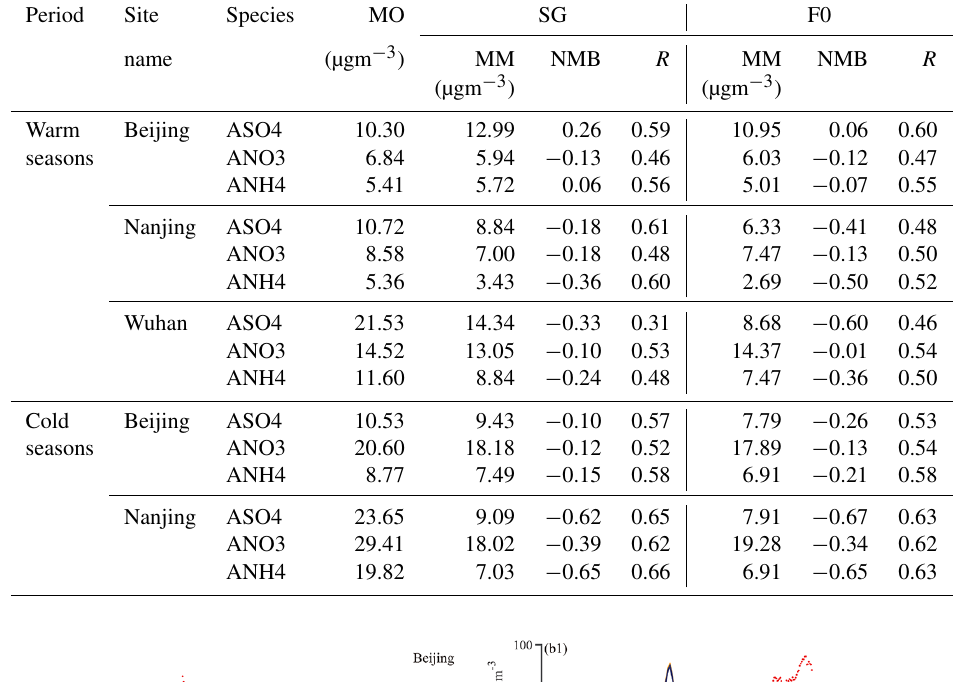
Table 4. Summary of statistics for hourly mass concentration of aerosol components in different seasons. MO, MM, NMB and R represent the mean value of the observations, the mean value of the model, normalized mean bias and correlation coefficients, respectively. ASO4, ANO3 and ANH4 represent sulfate, nitrate and ammonium, respectively.